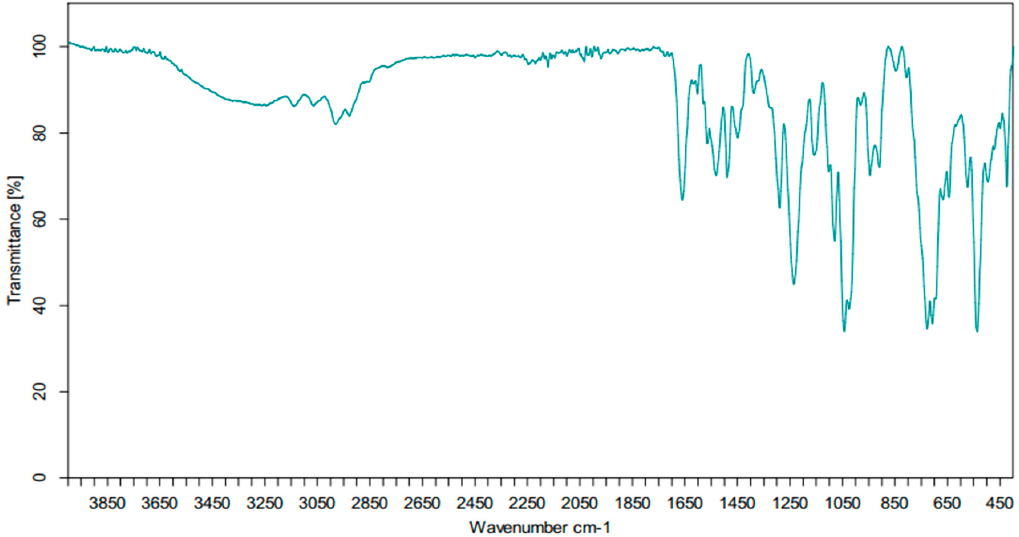
Figure 6. IR spectrum of compound ( 3 ).